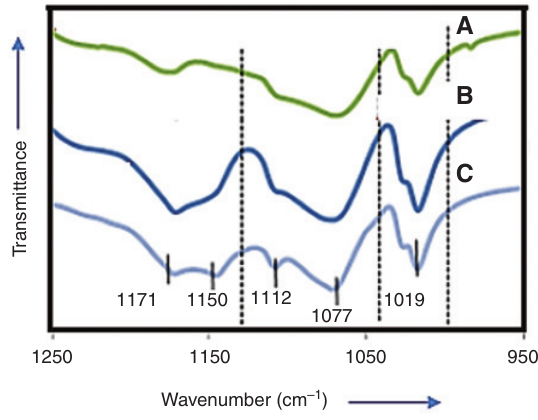
Figure 6: FTIR spectra of pure alum and the prepared composite samples.